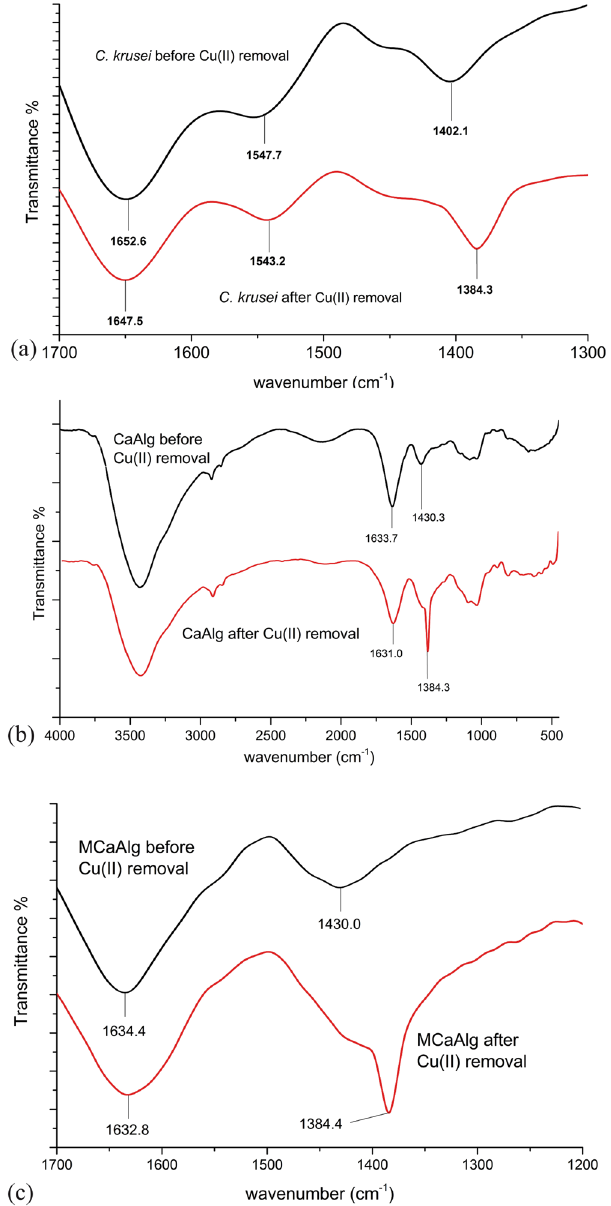
Figure 2. IR spectrum of ( a ) C . krusei ( b ) CaAlg ( c ) MCaAlg before and after copper(II) removal.